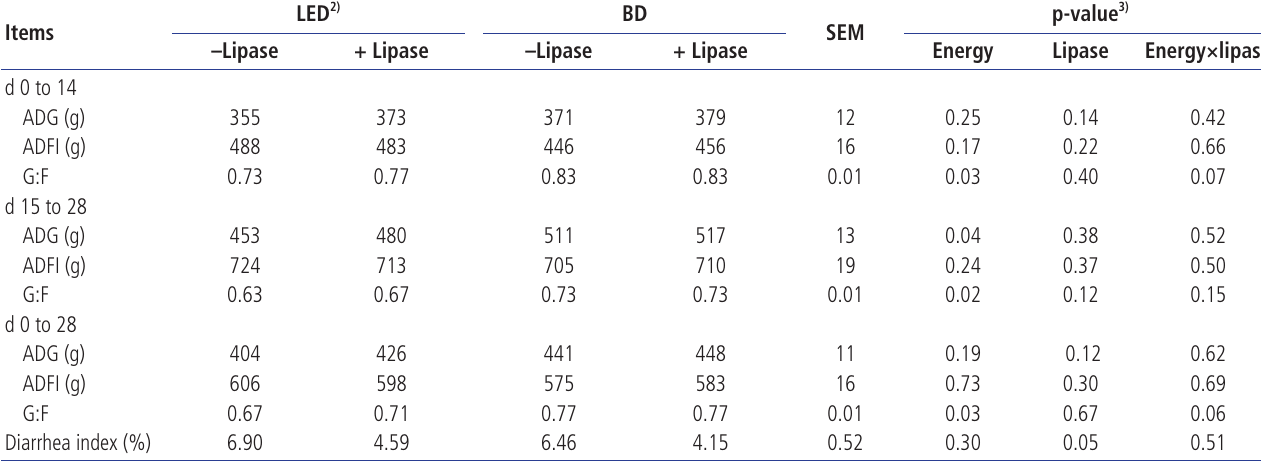
Table 2. Effects of dietary energy and lipase levels on growth performance in weaning pigs 1)